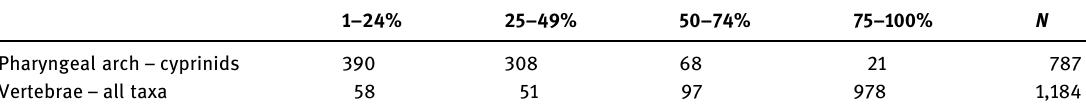
Table 2: Completeness of cyprinid pharyngeal arches and vertebrae; sample of 1,971 layer 3